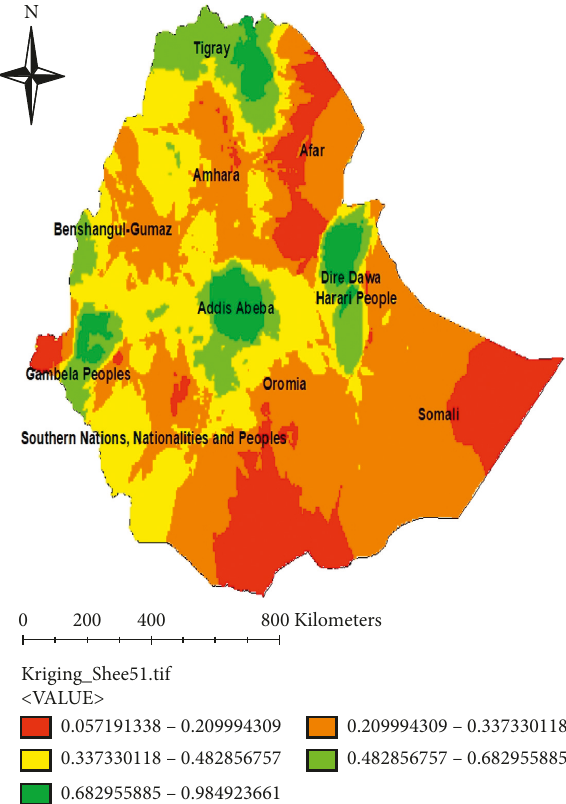
Figure 5: Spatial interpolation of institutional delivery areas across regions in Ethiopia, 2016 (source: shape file from CSA, 2013, done using ArcGIS version 10.6).